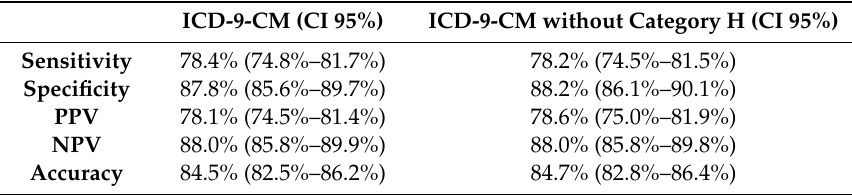
Table 4. Sensitivity, specificity, positive predictive value (PPV), and negative predictive value (NPV) of identification of polypathological patients through ICD-9-CM with repsect to gold-standard clinical